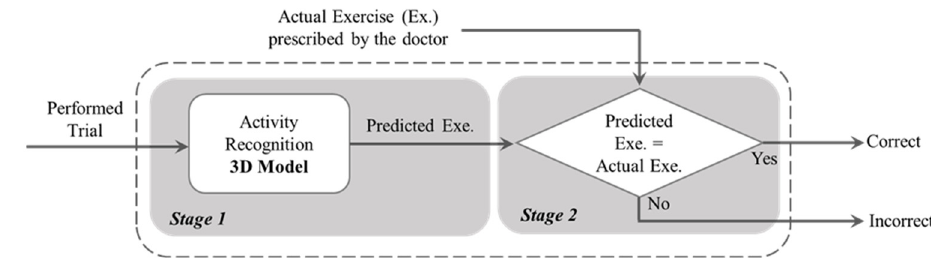
Figure 3. Schematic of the two-stage model for classifying the correct and incorrect